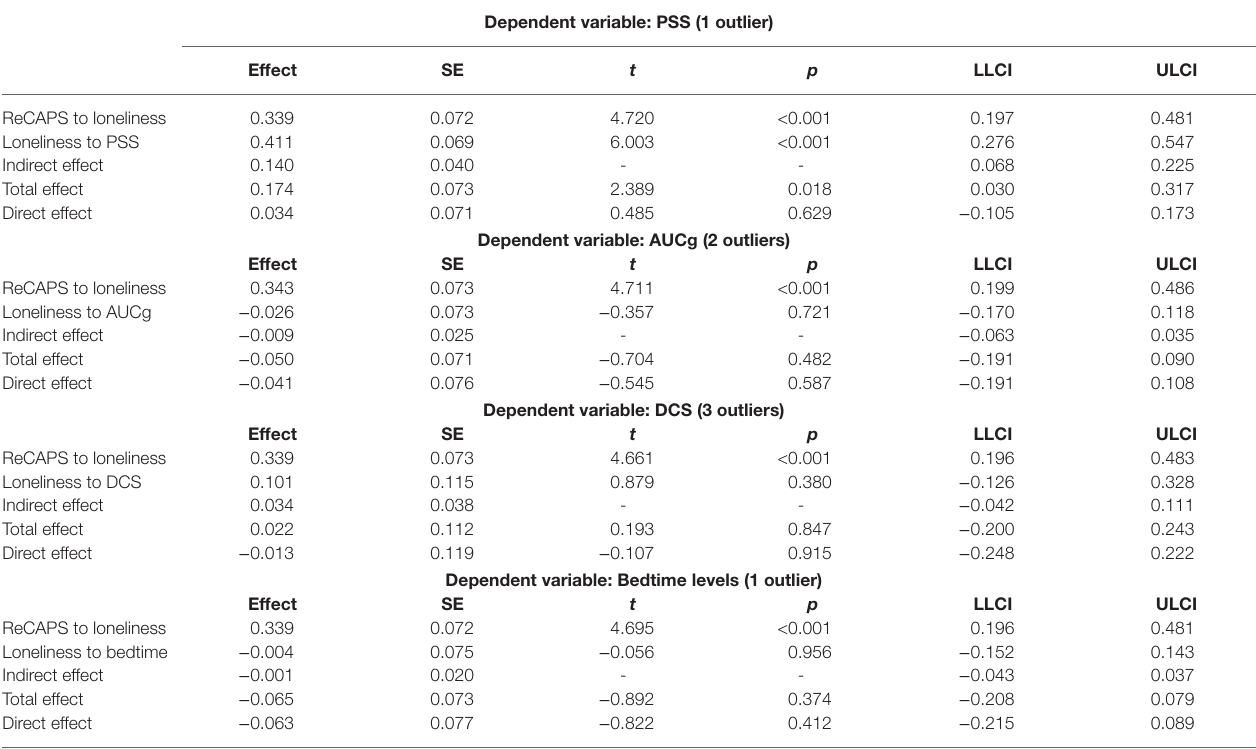
TABLE 5 | Adjusted mediation models of the relationship between ELS (measured by ReCAPS) as predictor and perceived stress and cortisol levels (AUCg, DCS, and bedtime) as dependent variables via loneliness. Dependent variable: PSS (1